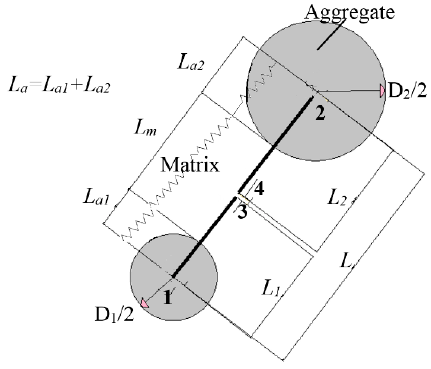
Figure 4. Axial interaction between aggregate centers.